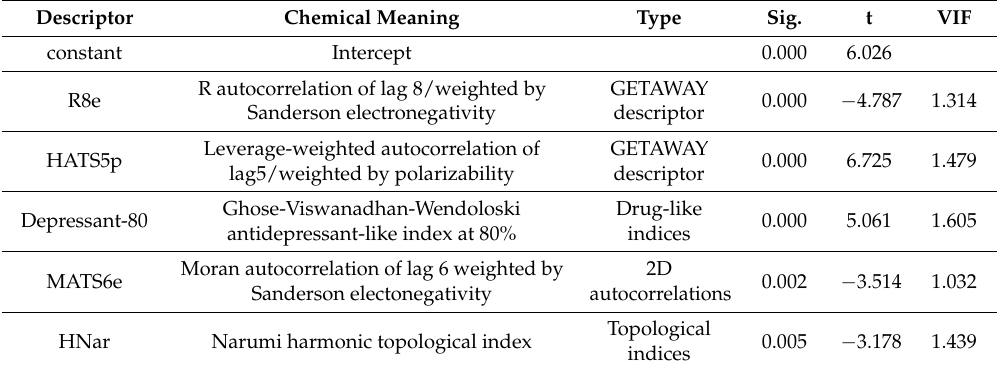
Table 3. Selected descriptors of multiple linear regression.